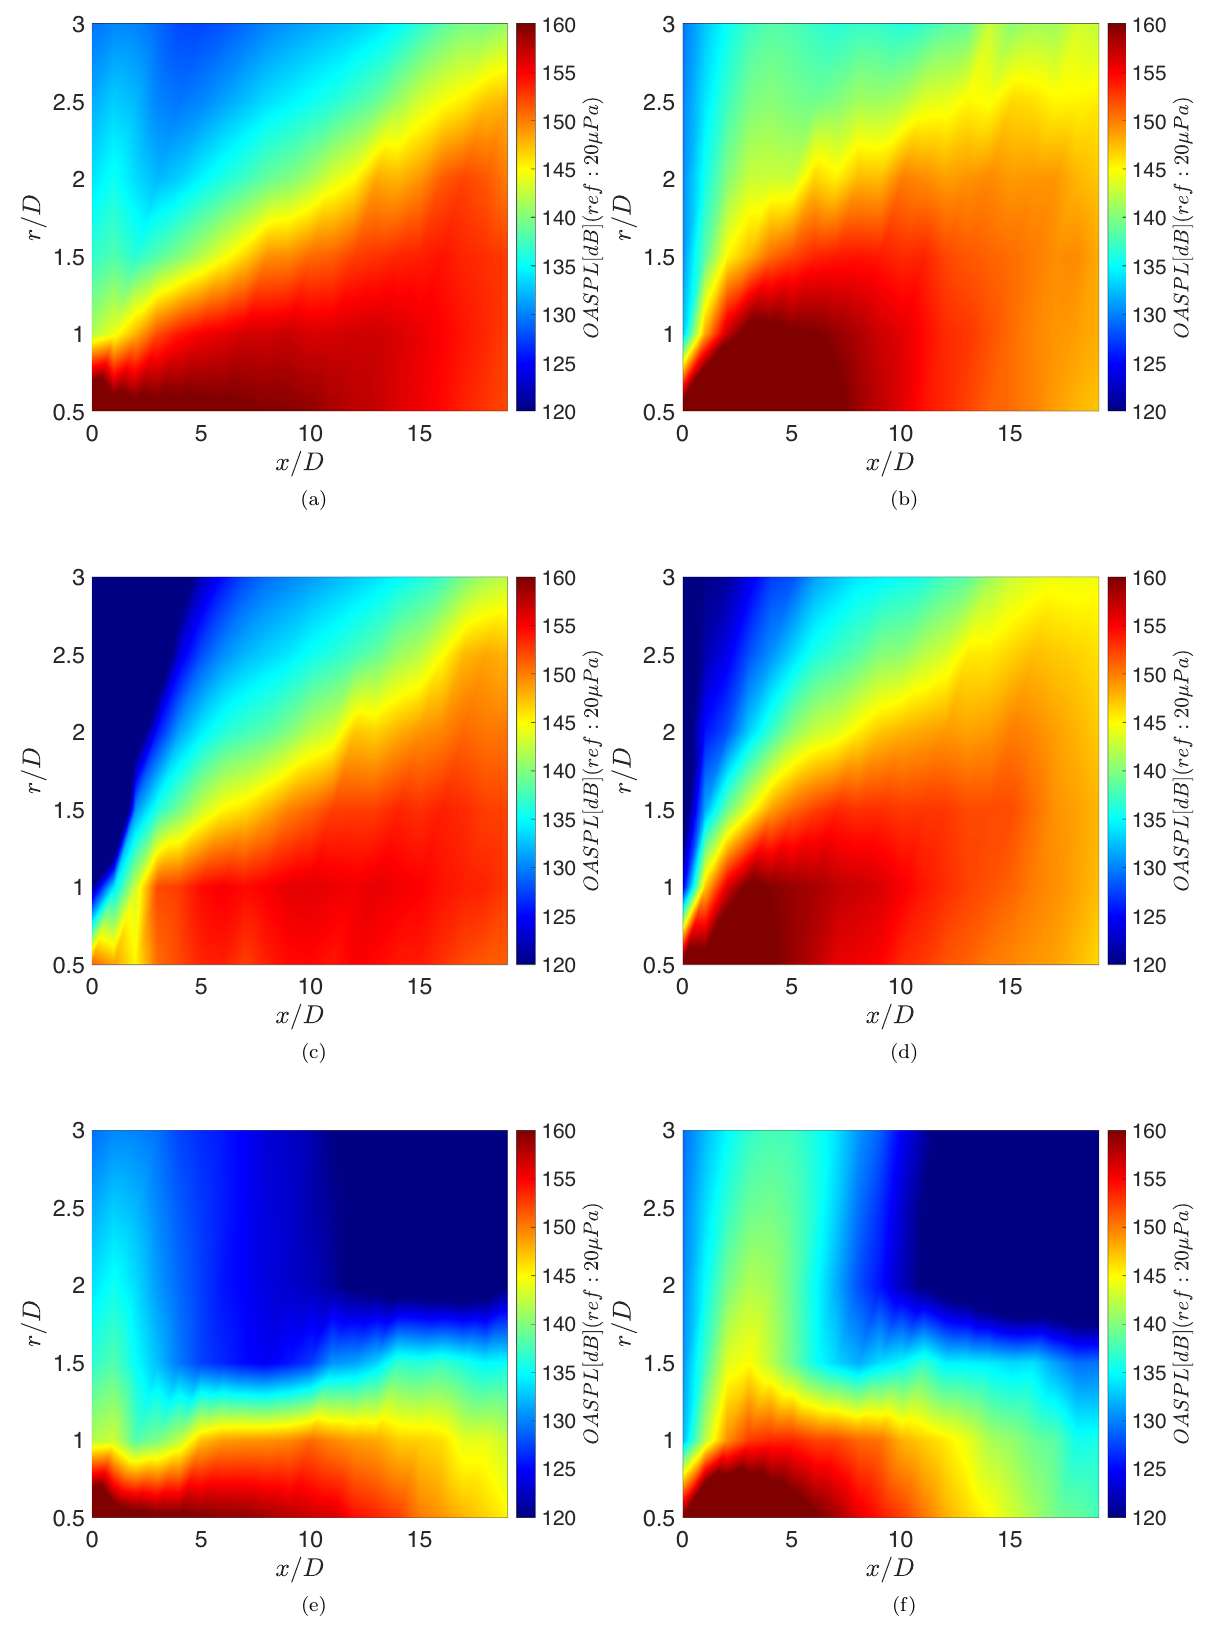
Figure 4. OASPL contour maps for d = 0.025 (a, c, e) and d = 0.2 (b, d, f): (a) and (b) original signals; (c) and (d) hydrodynamic components; (e) and (f) acoustic